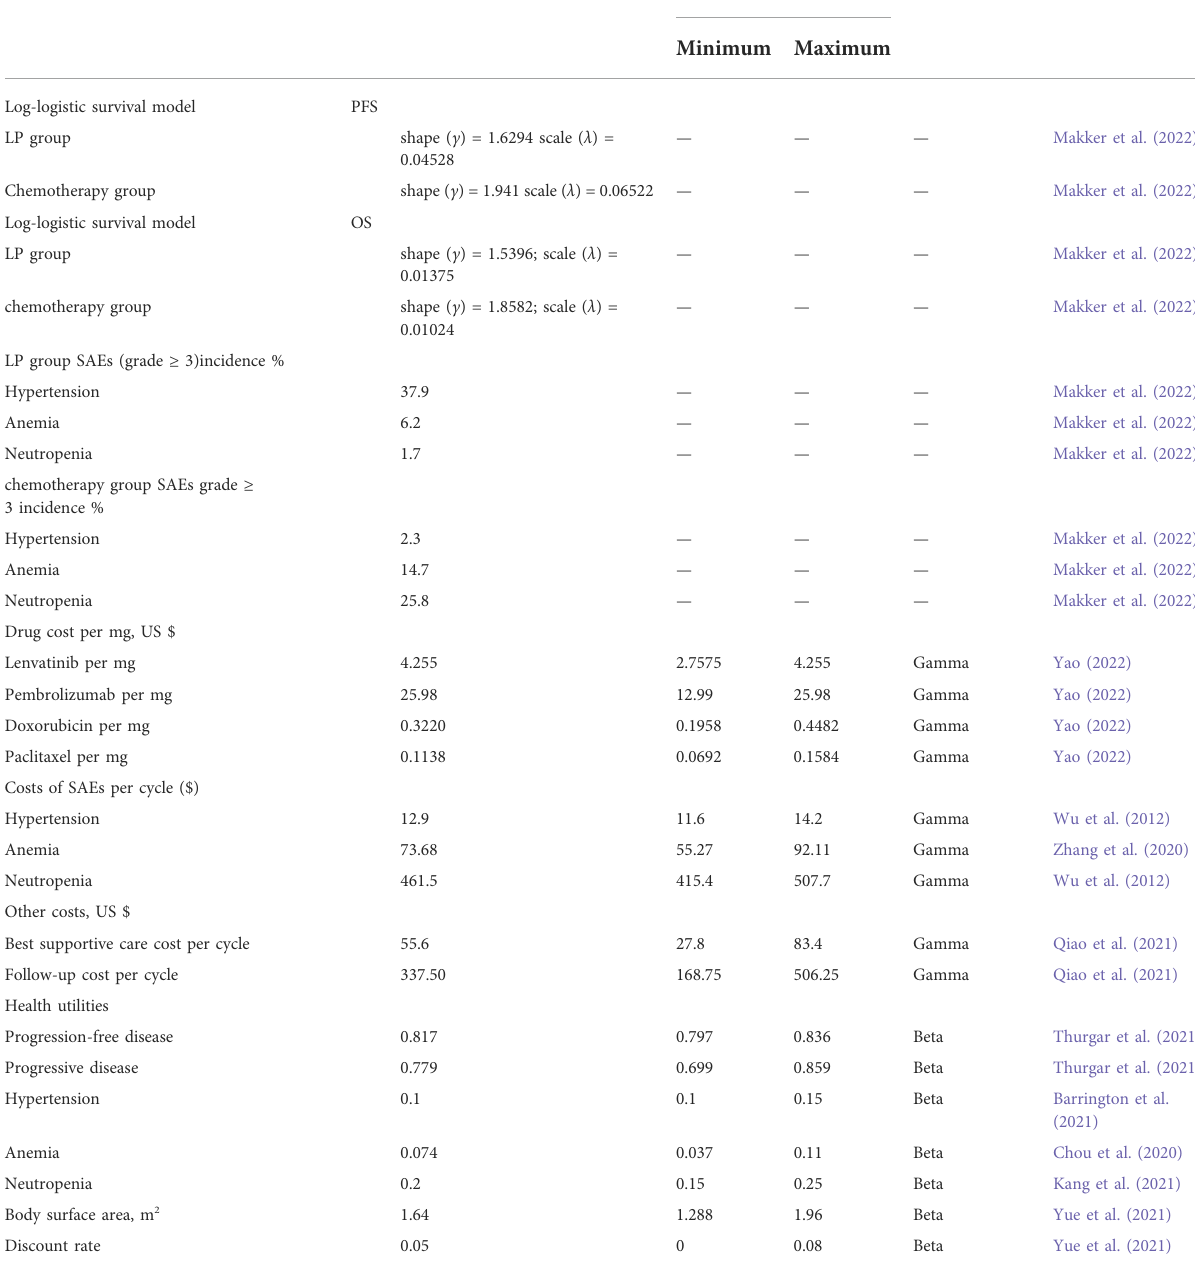
TABLE 1 Model economic parameters and the range of the sensitivity